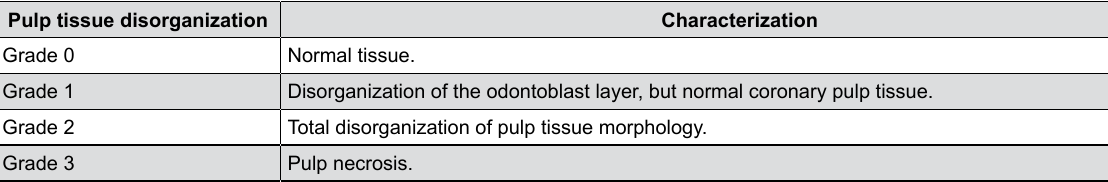
Figure 3- Classification of pulp tissue